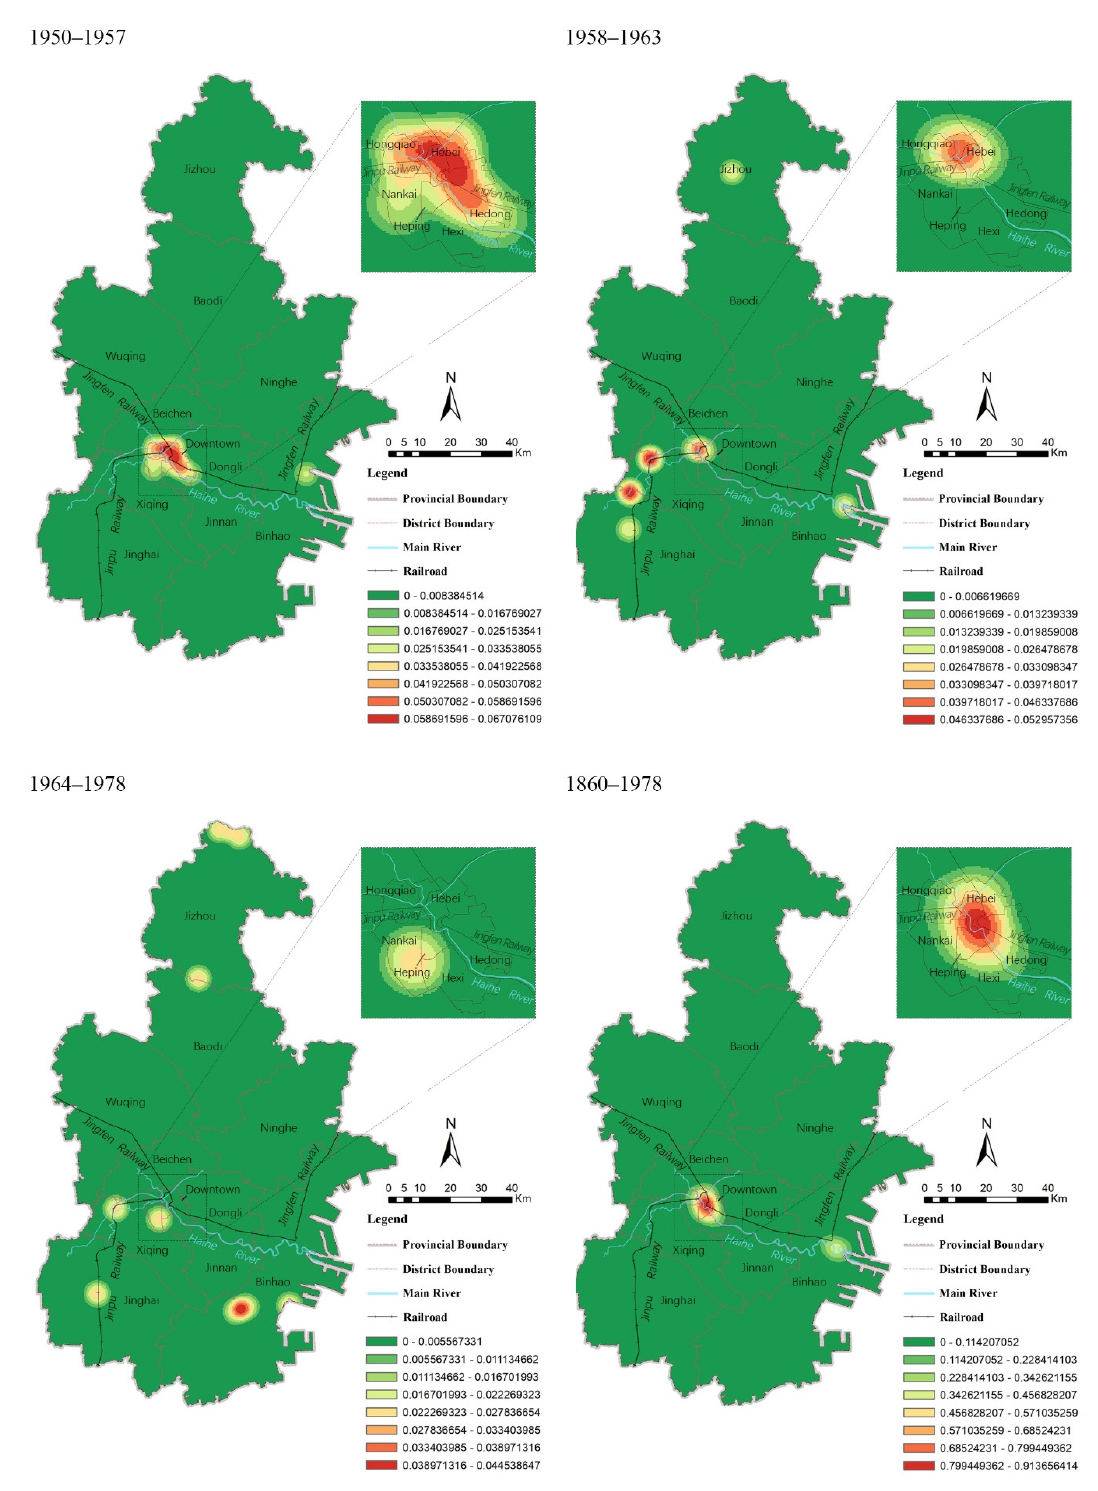
Figure 3. Distribution of kernel density by period of Tianjin’s industrial heritage.